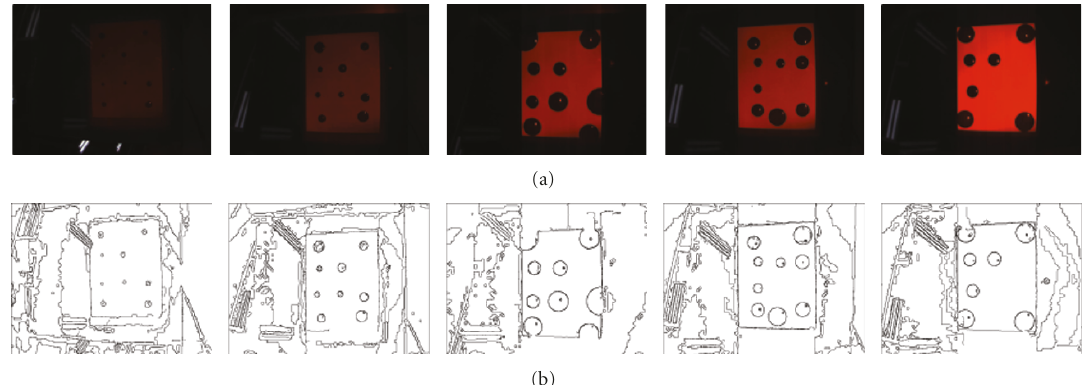
Figure 14: Images in the top row were captured by the proposed pro-cam design. Images in the bottom row result from Canny edge detection using the proposed multiscale visual detection scheme with parallel implementation.